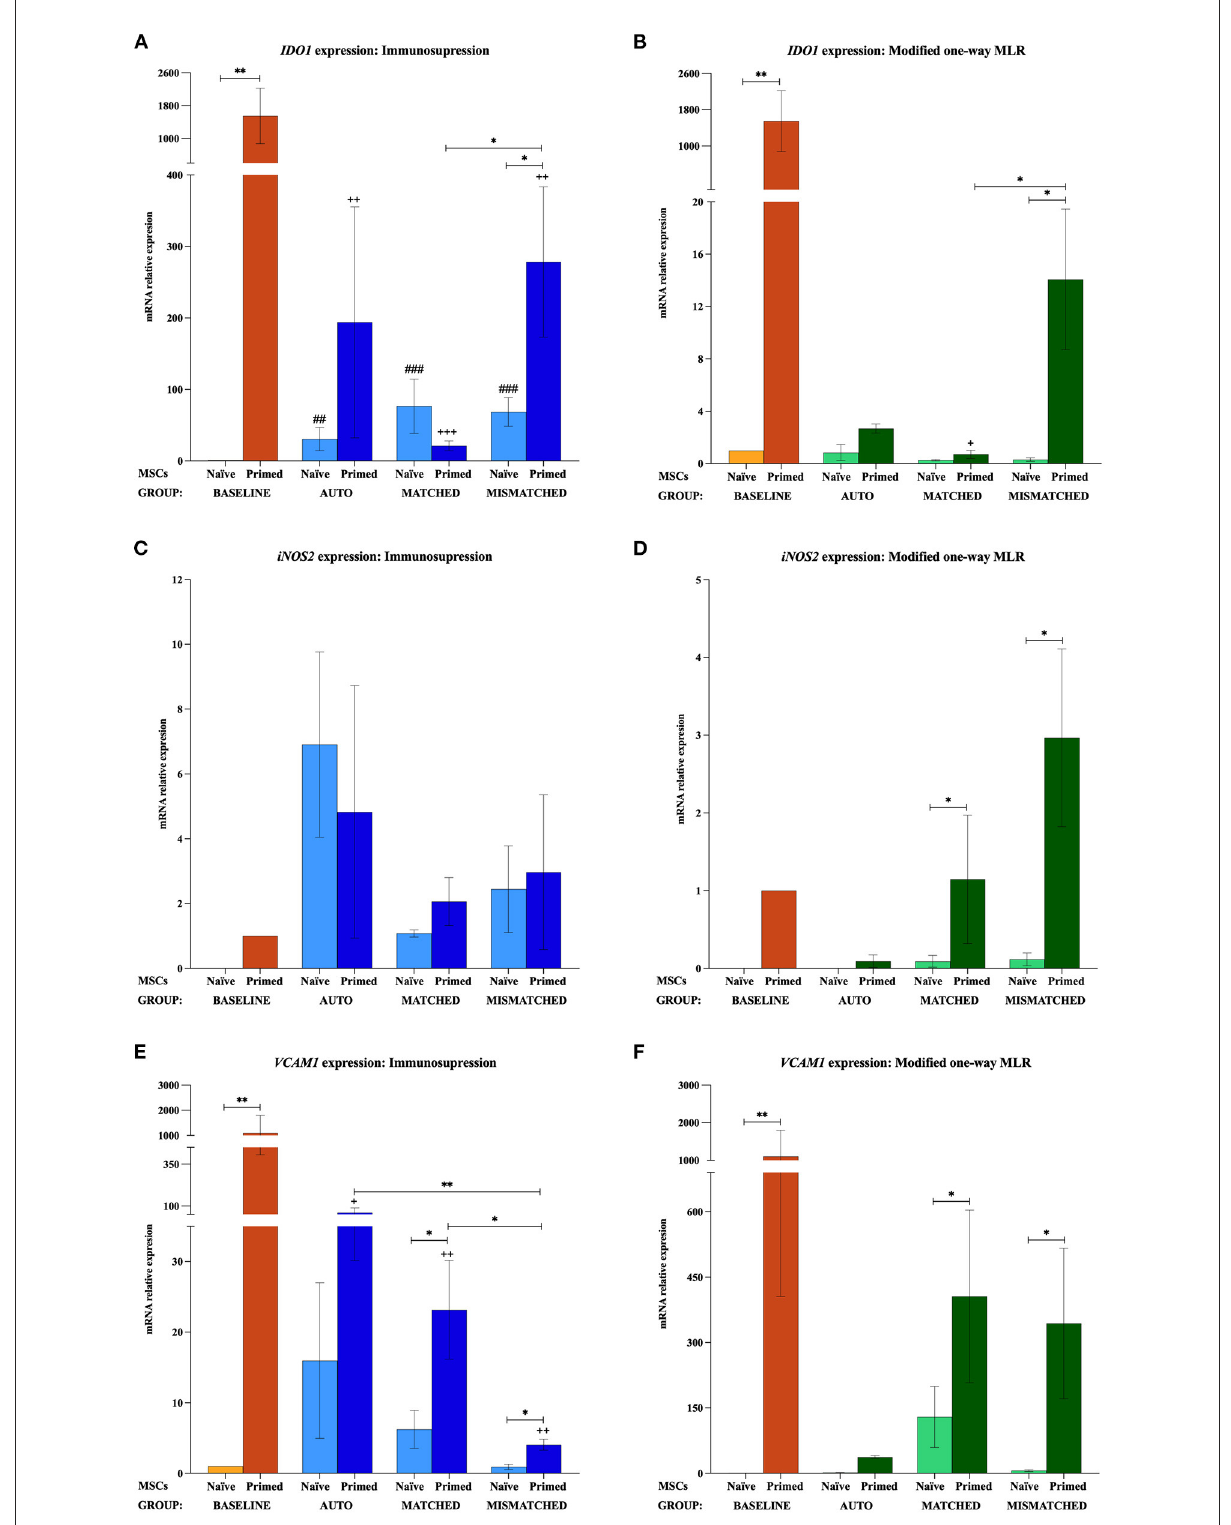
FIGURE4 Changes in indoleamine 2,3-dioxygenase 1 ( IDO1 ), inducible nitric oxide synthase 2 ( iNOS2 ), and vascular cell adhesion molecule 1 ( VCAM1 ) expression by equine mesenchymal stem cells (MSCs) in the different scenarios (A) IDO1 , (C) iNOS2 , and (E) VCAM1 mRNA relative expression before (baseline; orange bars) and after equine MSC-naive (light blue bars) and MSC-primed (dark blue bars) were exposed in vitro to